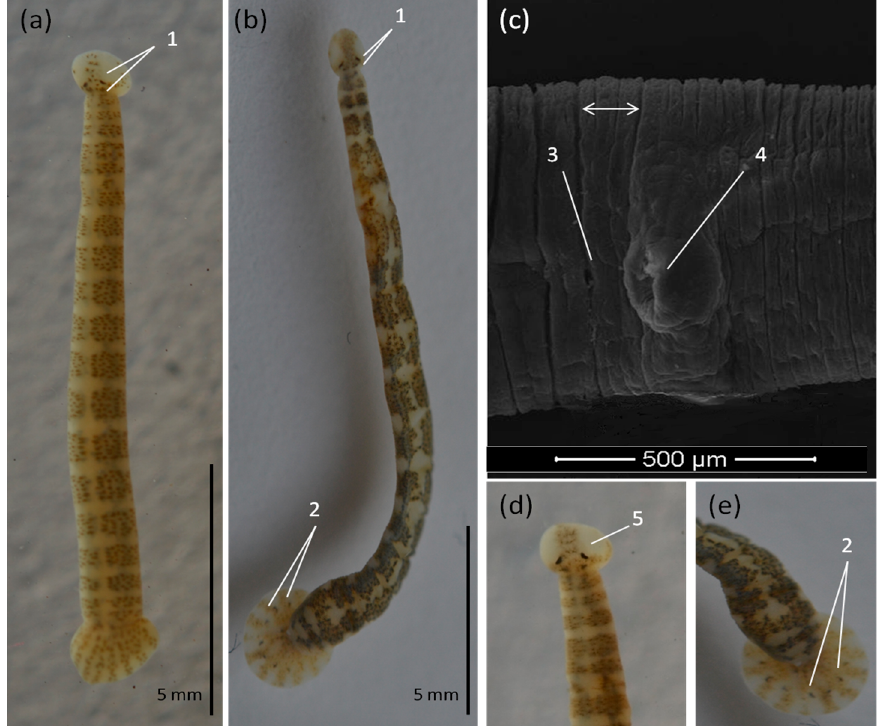
Figure 3. Morphology of Piscicola geometra (L., 1758): ( a , b ) body proportions and pigmentation of ethanol-fixed specimens from European part of Russia (left) and Western Siberia (right), ( c ) body fragment with gonopores (SEM), ( d ) anterior sucker and trachelosome and ( e ) part of urosome with caudal sucker. Numerical designations: 1—eyes, 2—punctiform eye-like spots, 3—female genital opening, 4—male genital opening and 5—depigmented area. Paratypes : There were 11 specimens from the aquatic vegetation of the Temernik River in the Rostov Region of Russia, leg. E. Matveenko (28-X-2015); 12 specimens were from the benthic samples of the Bukhtarma reservoir in the Irtysh River, Kazakhstan, leg.